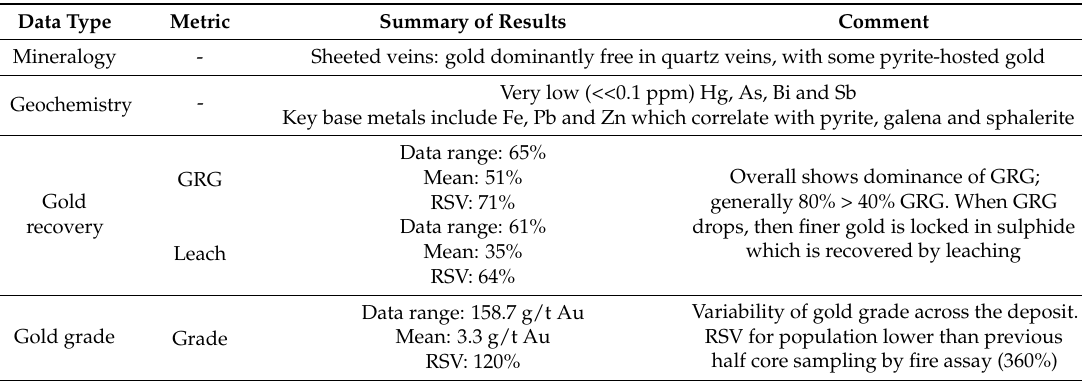
Table 5. Summary of data from the geometallurgical drilling programme across the